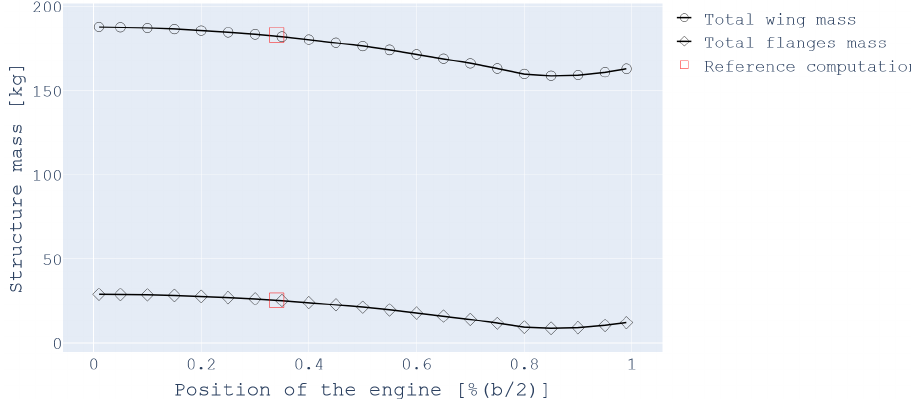
Figure 9. Effect of the location of the engine on the wing and caps